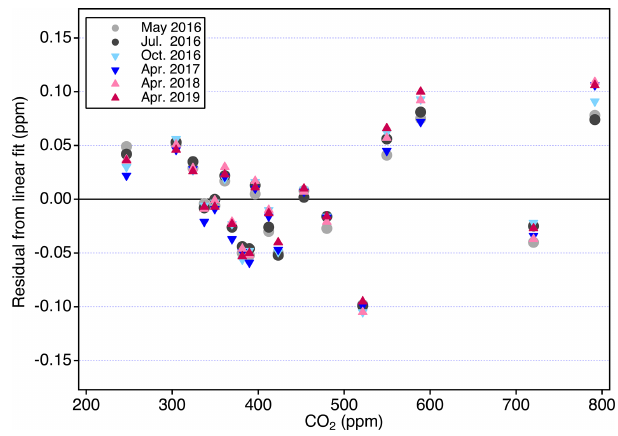
Figure 9. Residuals from a linear fit to analysis data obtained on 6 different days. The standard deviation of all residuals is 0.05ppm.